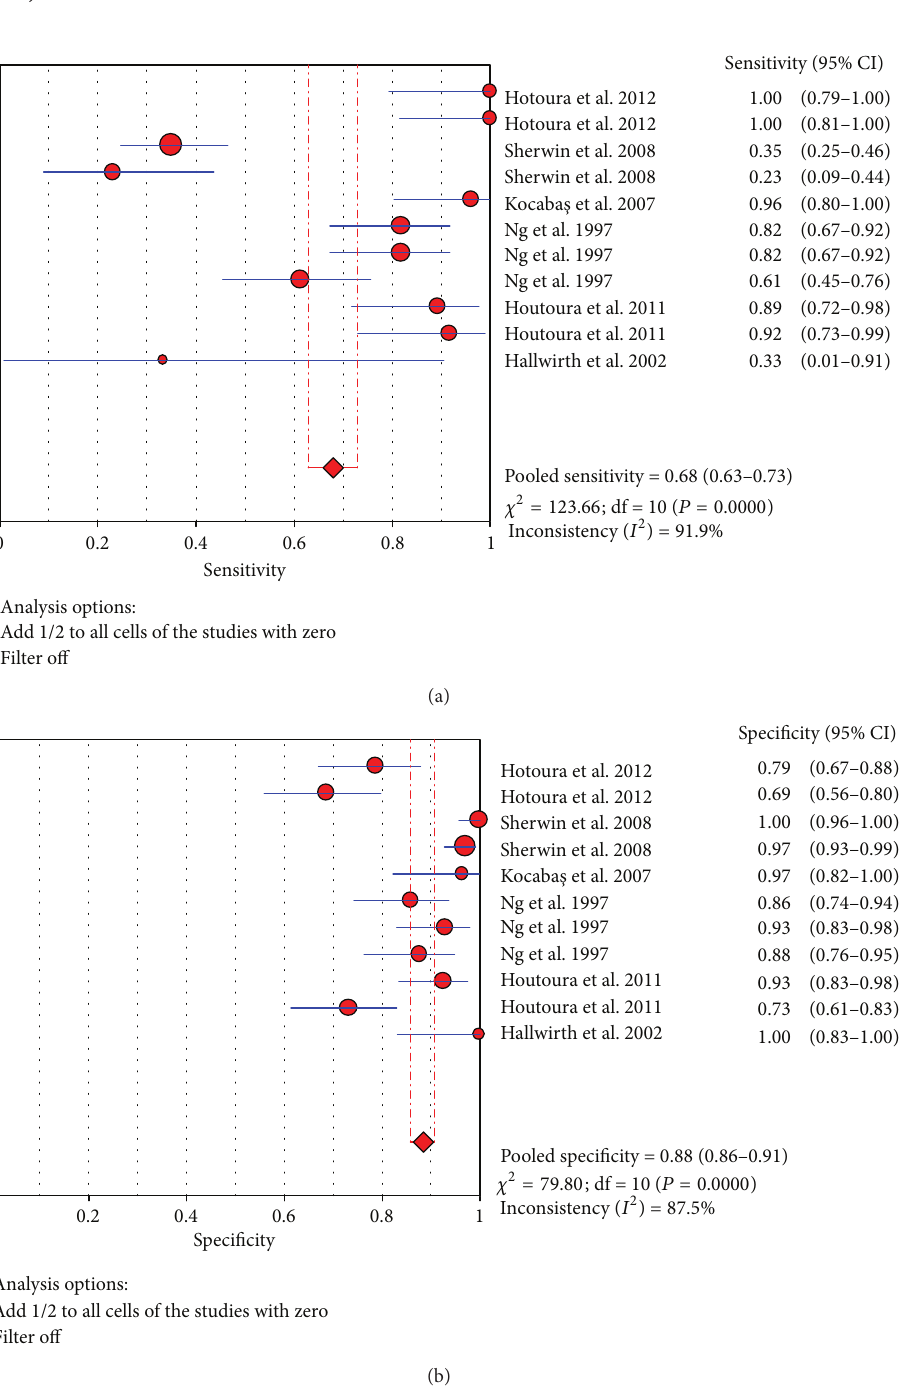
being 0.017. The pooled diagnostic accuracy ( 𝑄 ∗ ) of 0.8710 with the standard error was